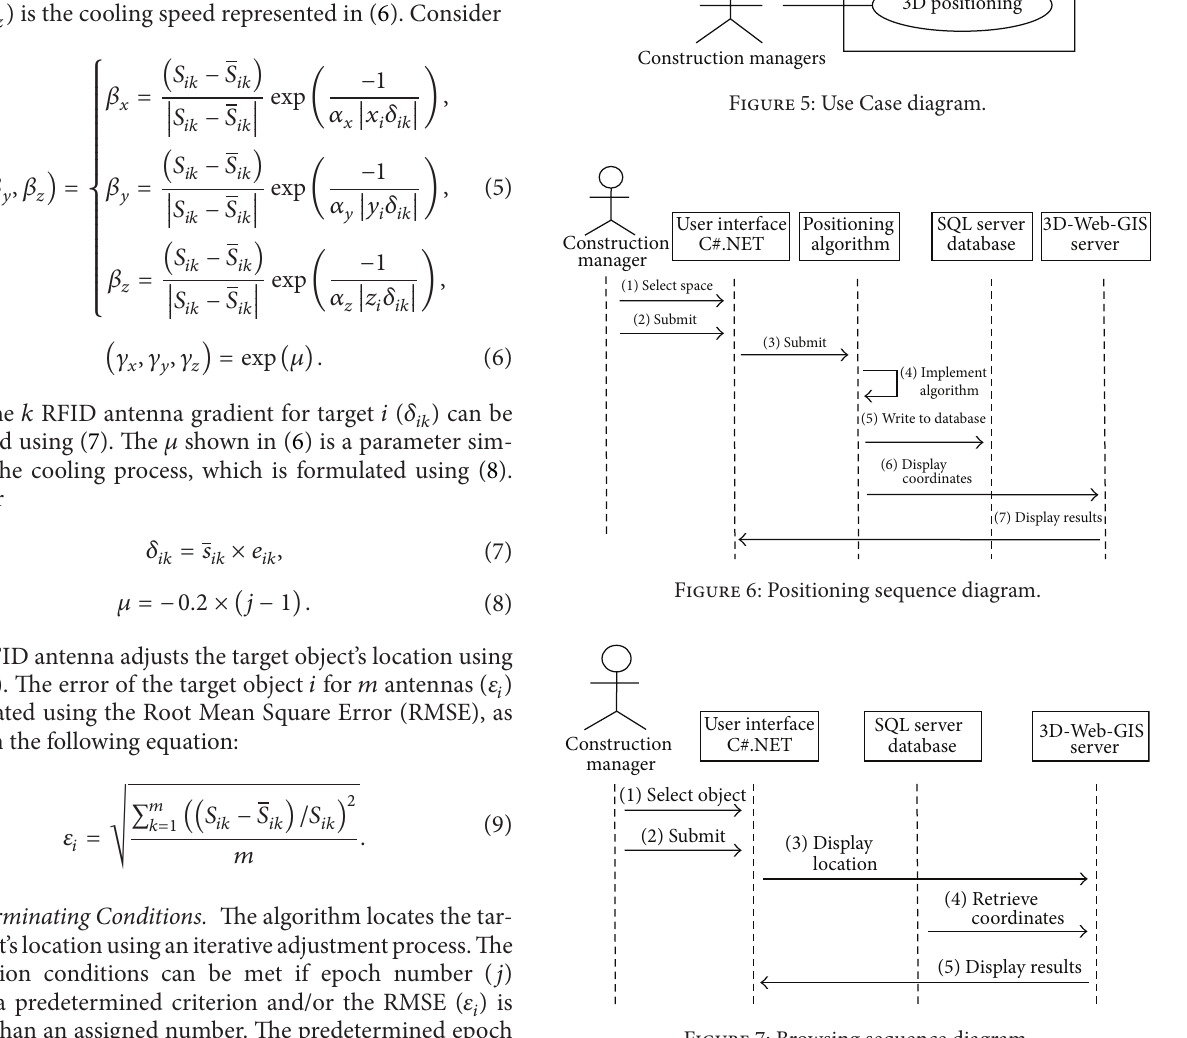
Figure 7: Browsing sequence